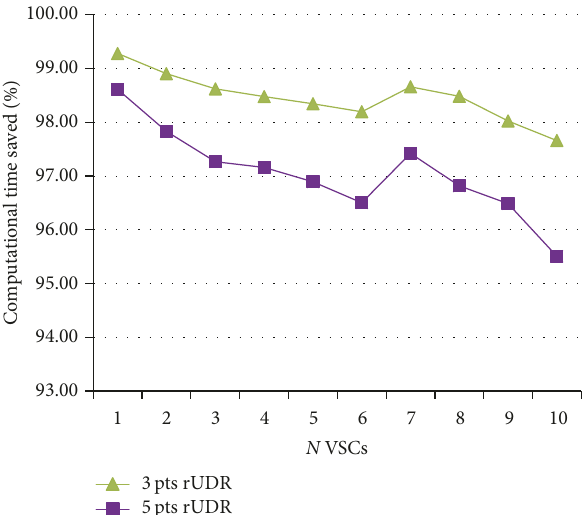
Figure 6: Predicted VgaTHD using MCS, rUDR 3 pts, and rUDR 5 pts under Filter Variation.